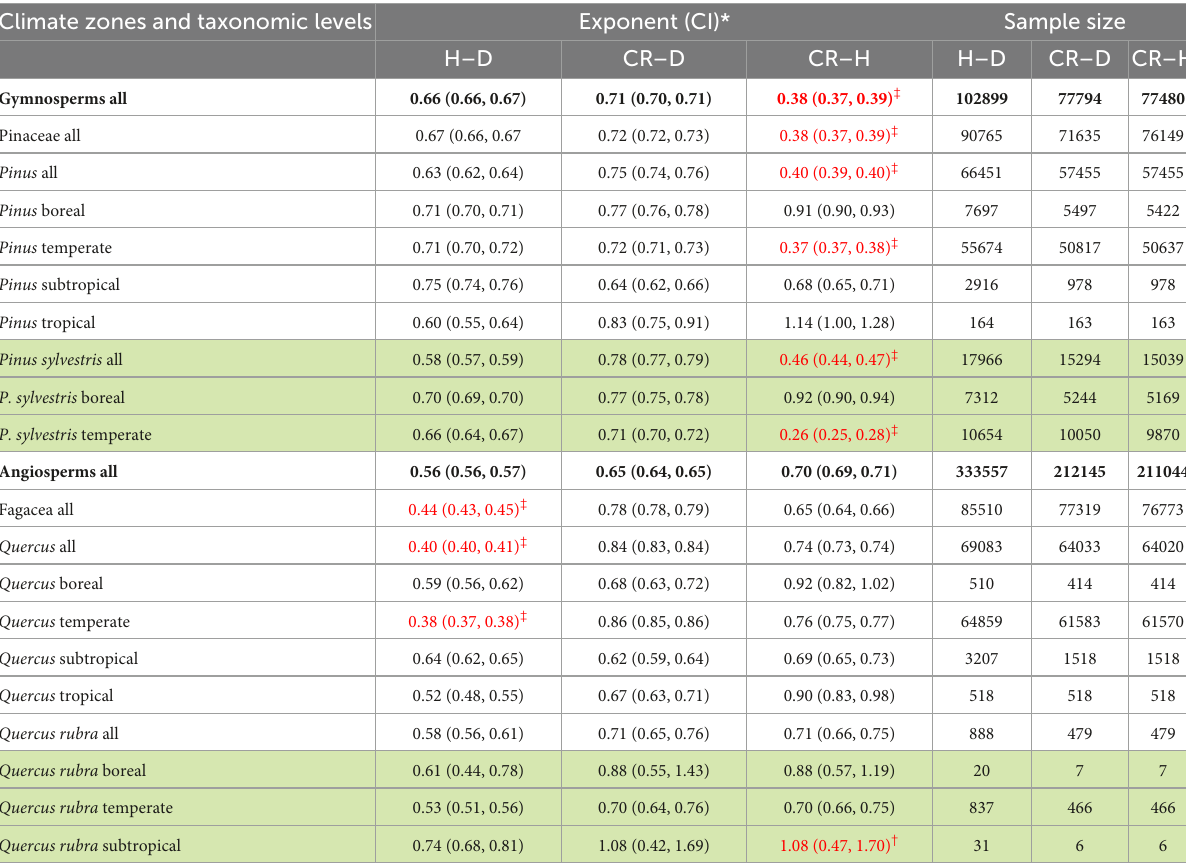
TABLE 2 Variations in the OLS estimates of the allometry exponents of stem height with diameter at breast height (H–D), crown radius with diameter at breast height (CR–D) and crown radius with stem height (CR–H) scaling with taxonomic levels and climate zones. Climate zones and taxonomic